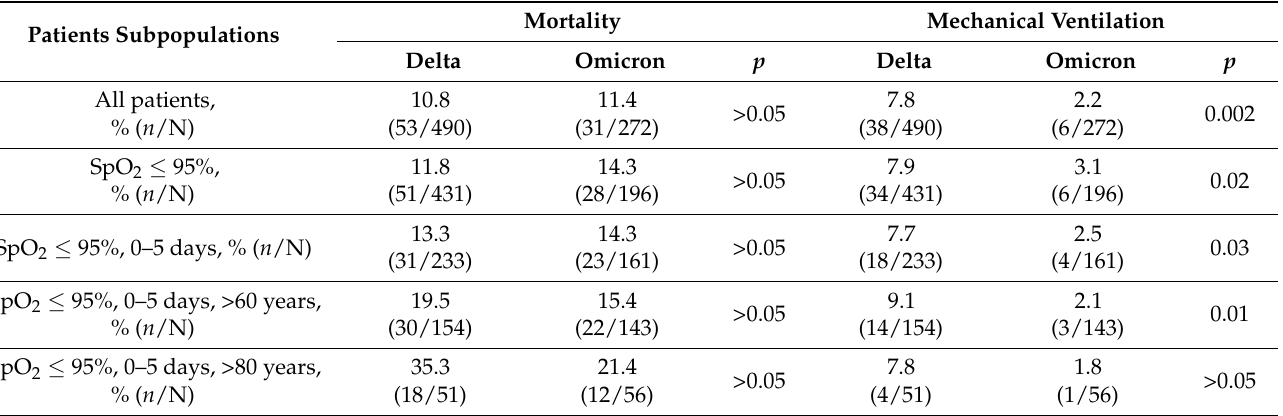
Table 6. Twenty-eight-day mortality and the need for mechanical ventilation in patients treated with remdesivir during periods of Delta and Omicron variant dominance analyzed in all patients, only those with oxygen saturation ≤ 95%, including administration of remdesivir within 5 days of symptom onset and those aged over 60 or 80 years.